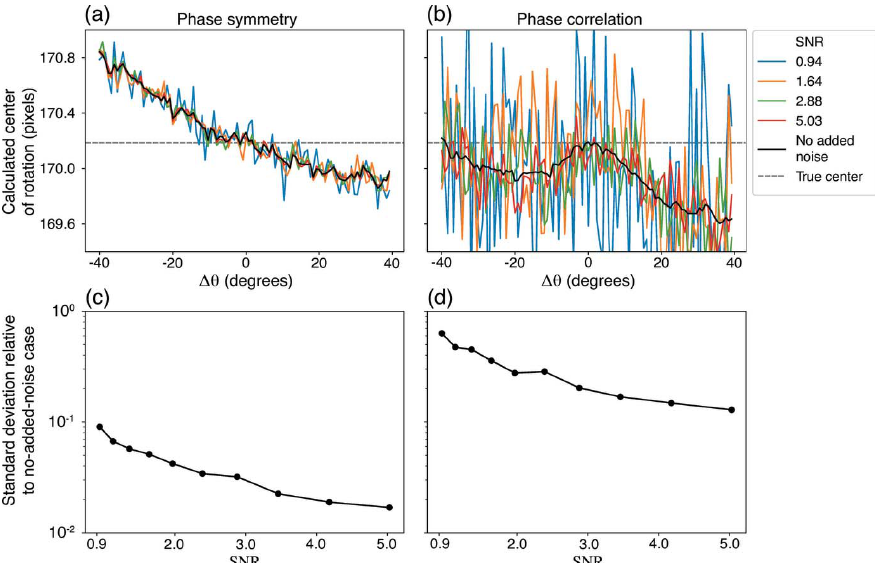
Figure 5 Center of rotation error (COR) recovered using the phase symmetry and phase correlation methods when using a relection pair of images obtained at rotational angles that are not exactly 180 (cid:2) apart: that is, with at angles (cid:2) 0 and (cid:2) 0 + 180 (cid:2) + (cid:2) (cid:2) . At each instance of SNR (Table 1), 100 instances of Poisson noise were generated. At the top we see the mean values for the recovered COR values from the phase symmetry ( a ) and phase correlation ( b ), while in the bottom row we see the standard deviation of the recovered COR values from the phase symmetry ( c ) and phase correlation ( d ) methods. Both methods deviate away from the true center as (cid:2) (cid:2) gets further from 0 (cid:2) , but with slightly less error and considerably lower fluctuations when using the phase symmetry